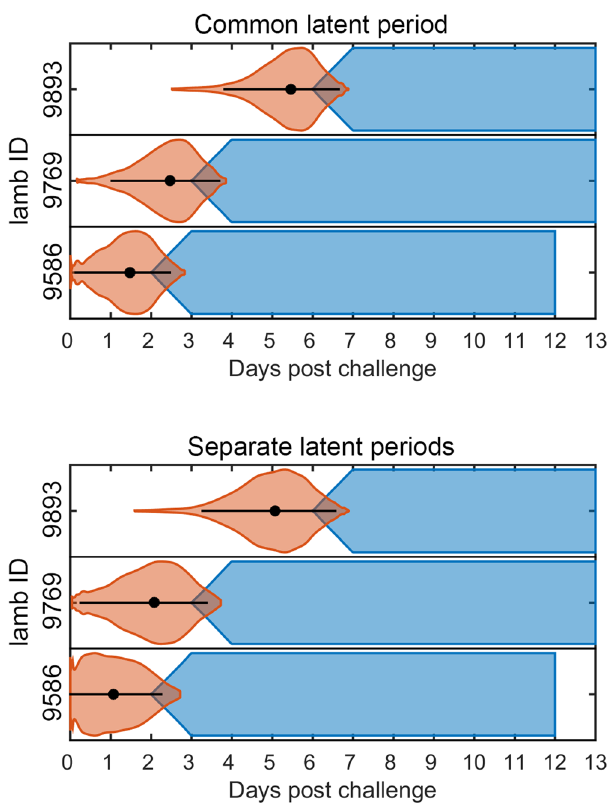
Figure 3. Inferred infection times for the FMDV in lambs transmission experiment. Orange violin plots showing the densities of the inferred infection times for the contact lambs assuming a common latent period (top panel) or separate latent periods (bottom panel) for inoculated and contact-infected lambs. The black circles and bars denote the posterior median and the 95% highest posterior density interval. The inferred cumulative probability of animals being infectious at each time point are shown in